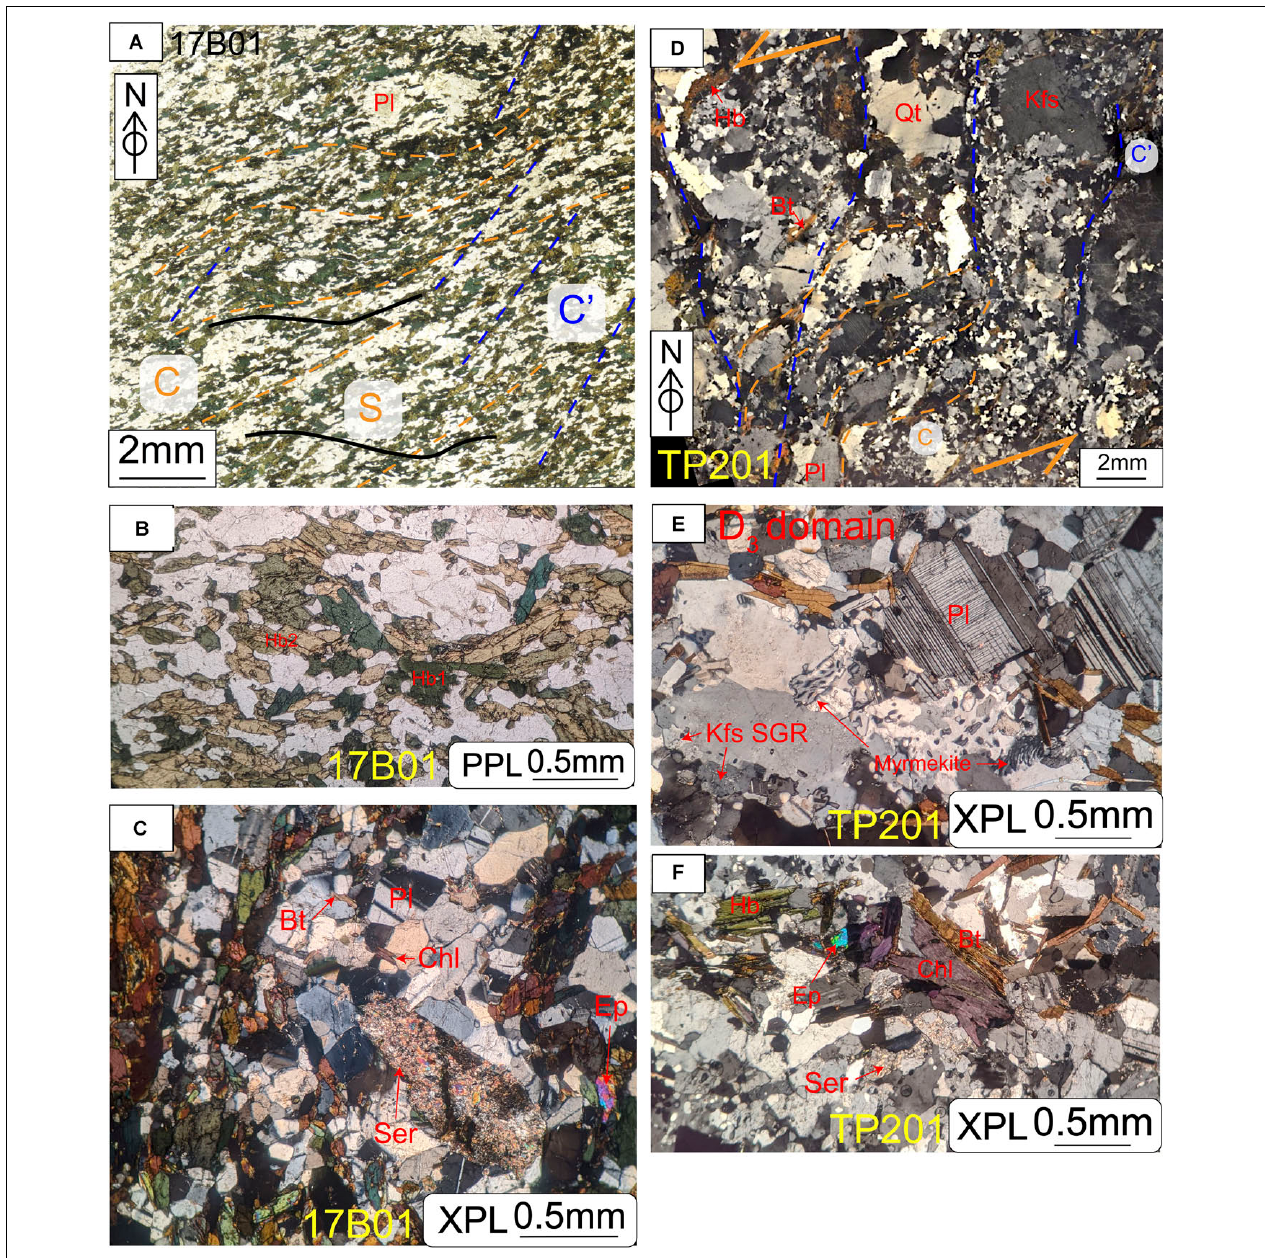
FIGURE 11 | Microphotographs showing microstructures and petrographic relationship of D 3 . (A) S/C/C’ fabric in amphibolite xenolith showing sinistral sense of shear. All fabrics are defined by the alignment of hornblende suggestive of amphibolite facies condition. (B) Detailed microphotograph under open nicol showing igneous hornblende (green) altered and replaced by secondary metamorphic hornblende (yellow) with granoblastic polygonal plagioclase matrix. (C) Granoblastic polygonal texture of plagioclase showing post-D 3 annealing with biotite growth along the plagioclase grain boundary. The retrograde overprint of the greenschist facies is shown by the chlorite, epidote and sericite. (D) C/C’ fabric in the Chenggong Tonalite showing sinistral sense of shear. The D 3 -domain is defined by the recrystallized finer-grained quartz-feldspar aggregates. The plasticity of feldspar indicated by fish structure and SGR shows amphibolite facies condition in agreement with the condition observed within amphibolite xenoliths. (E) Myrmekite precipitates between plagioclase and K-feldspar illustrating metasomatic process accompanying D 3 shearing. The K-feldspar is deformed by BLG and SGR. (F) Mineral assemblages of epidote, chlorite and sericite showing the greenschist facies post-D 3